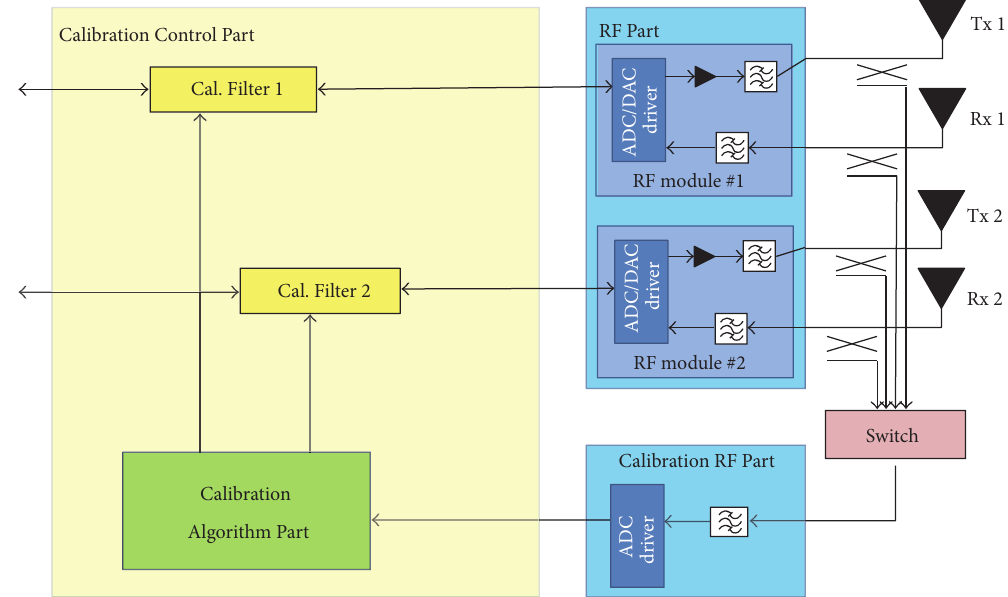
Figure 1: Block diagram of proposed calibration